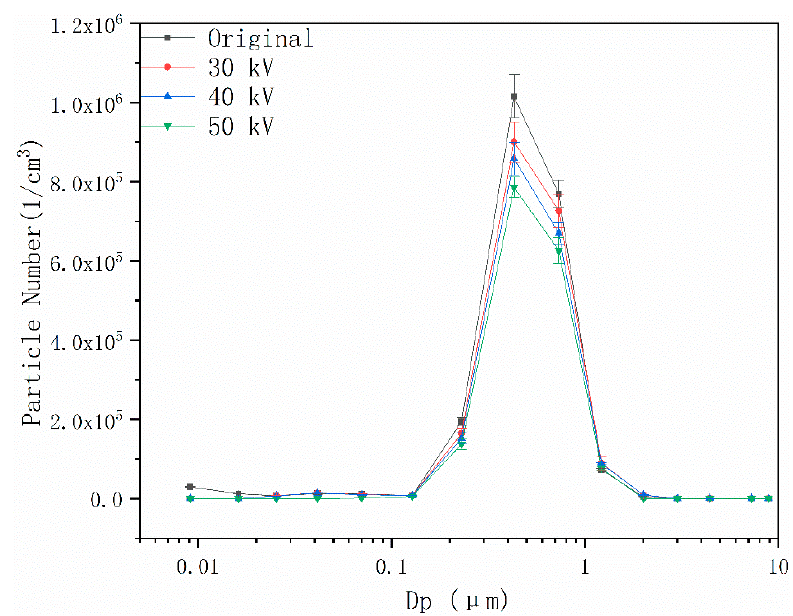
Figure 12. Number concentration of 0.5- μ m particles at different voltages.